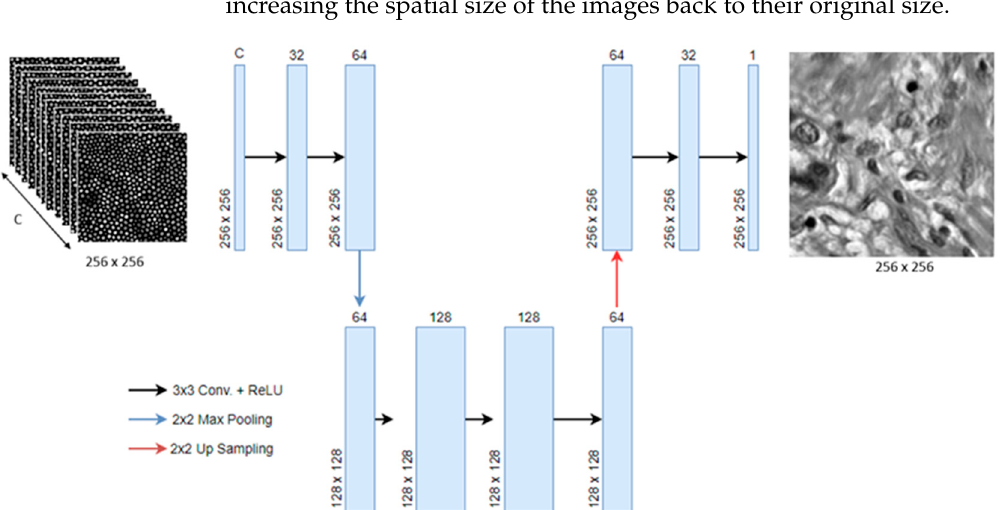
Figure 3. Proposed MFAE model. C represents the number of segments (channels) to be